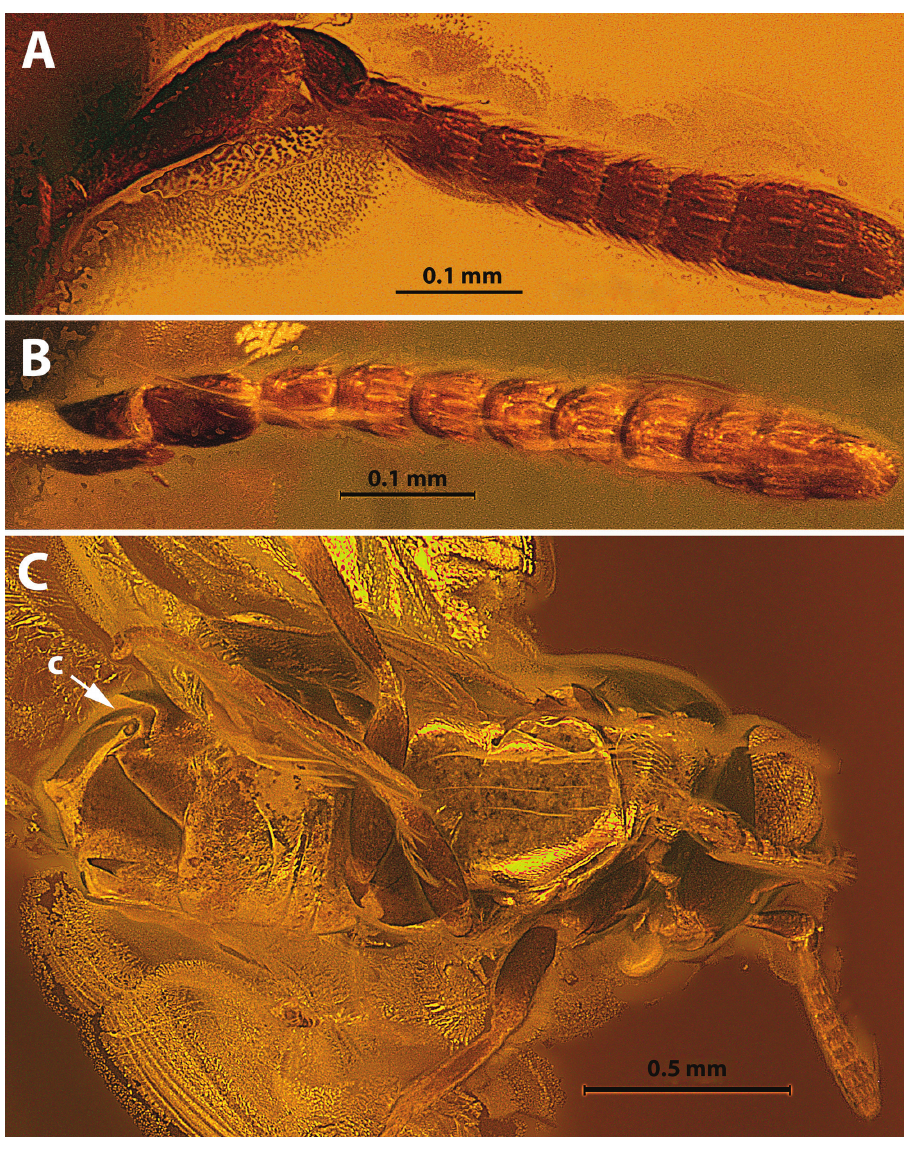
Figure 2. S. glaesaria , female, holotype A antenna lateral B antenna dorsal C habitus, right posterolateral (c – visible microtrichia, inner orbits parallel over much of height but ventrally divergent (Figs 1B, 3C, 5D); frontovertex broader than long, minimum distance between eyes about 0.4× head width; ocelli normal in size, forming about 100° angle; OOL about equal to posterior ocellar diameter (Figs 3C, 5B); OOL:POL:LOL:OCL about 1.5:6:3.5:0.8; oc- cipital margin sharp; eye reaching occipital margin; antennal scrobe deep, not extended